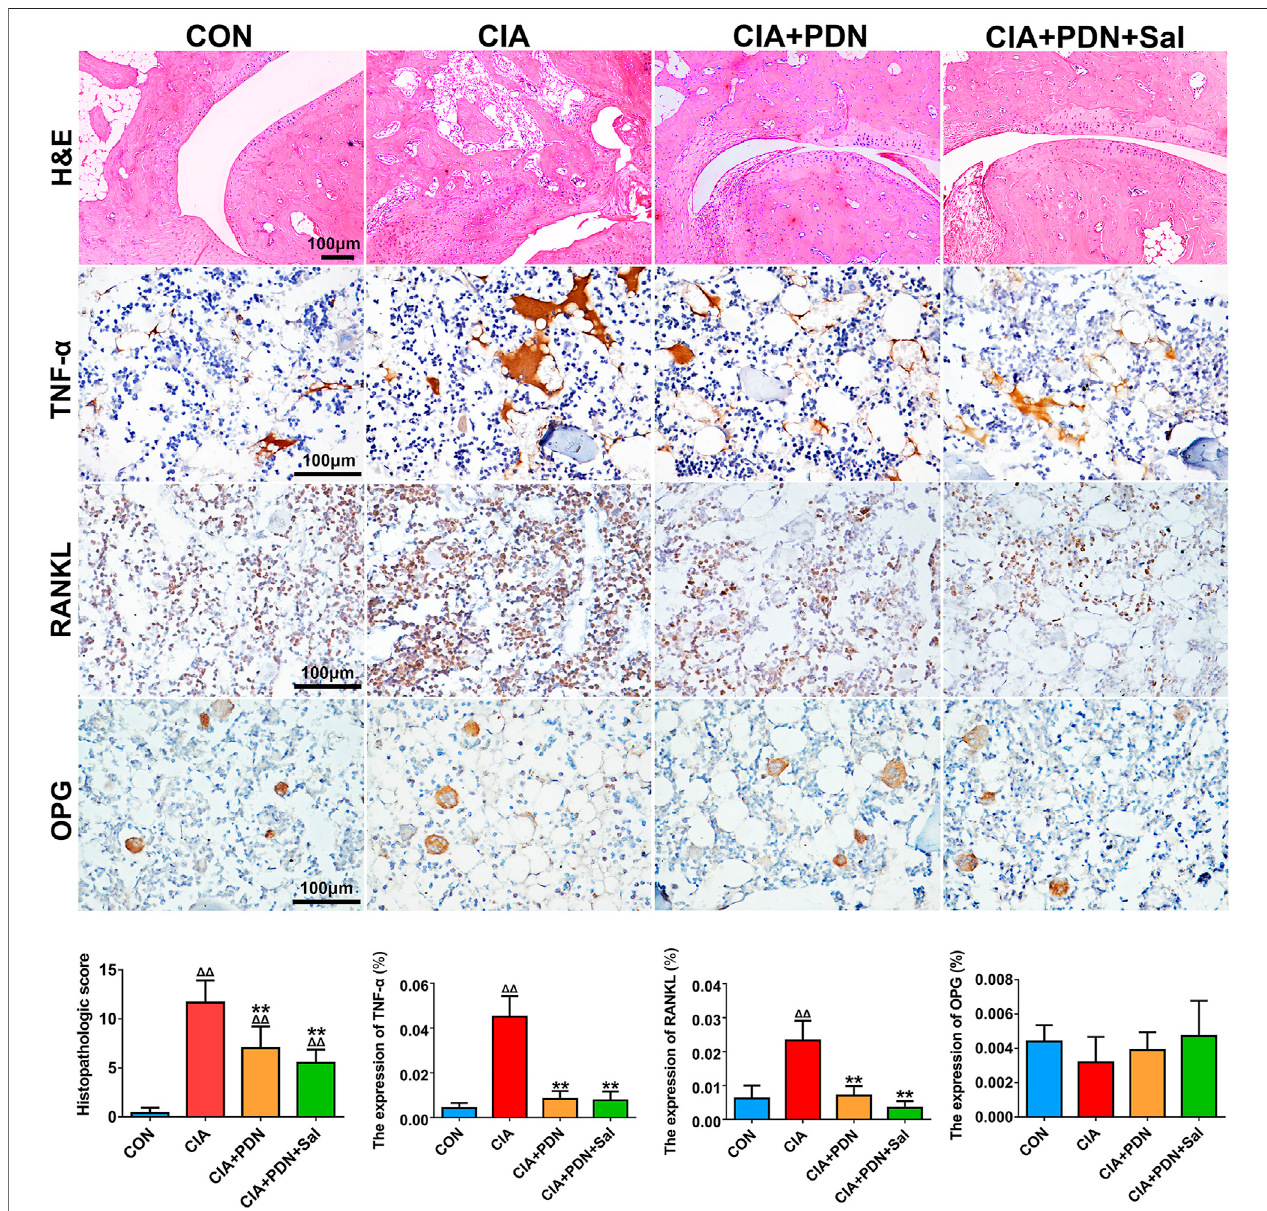
FIGURE 3 | Histological and immunohistochemical analyses of ankle joints in different groups of rats. Paraf fi n sections of the ankle joint were prepared for H&E staining and immunohistochemical staining of TNF- α , RANKL, and OPG. The expression ofbiomarkers was evaluated by semiquantitative analysis with Image-Pro Plus software. ΔΔ p < 0.01 vs. CON, ** p < 0.01 vs. CIA, # p < 0.05 vs. CIA+PDN ( n (cid:1)